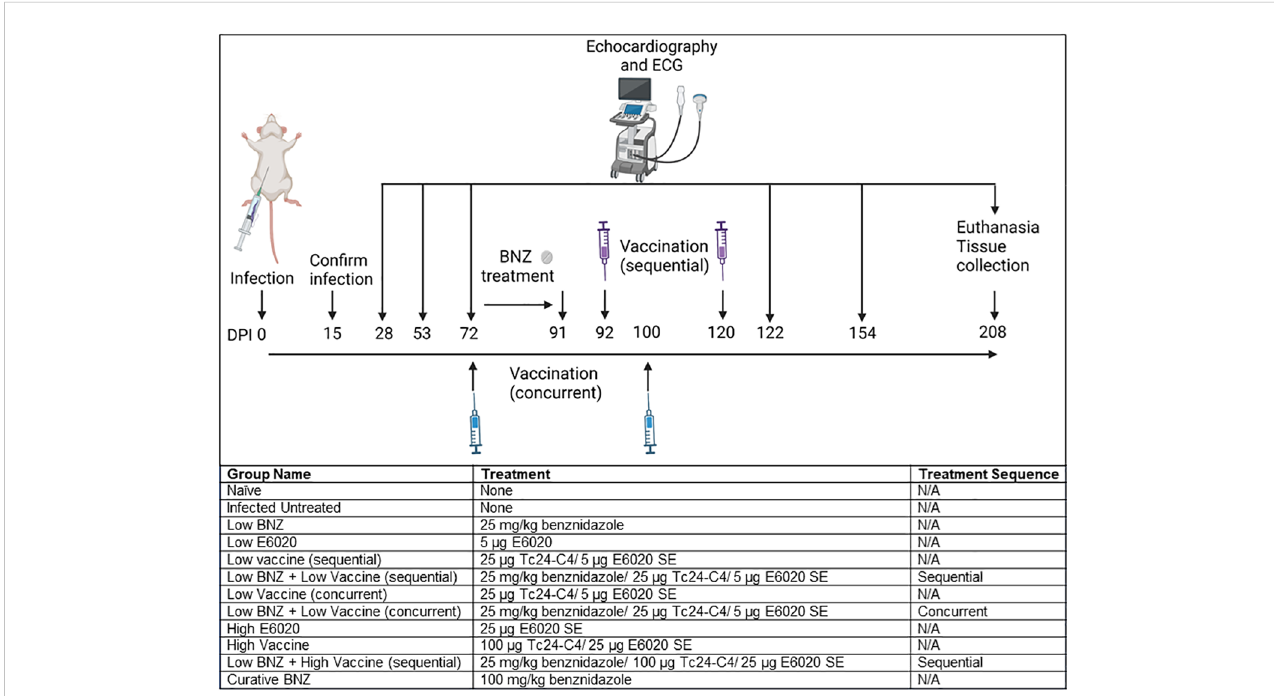
FIGURE 1 Study Timeline and experimental treatment groups. Mice were infected by intraperitoneal injection at day 0. Infection was con fi rmed at 15dpi, then echocardiography and electrocardiograms (ECG) were performed at 28dpi, 53dpi and 70dpi. Mice randomly assigned to treatment groups as indicated were treated beginning 70dpi and follow up echocardiography and ECGs were performed at approximately 122dpi, 154dpi, and 208dpi. All mice were euthanized at approximately 209dpi. Image created with